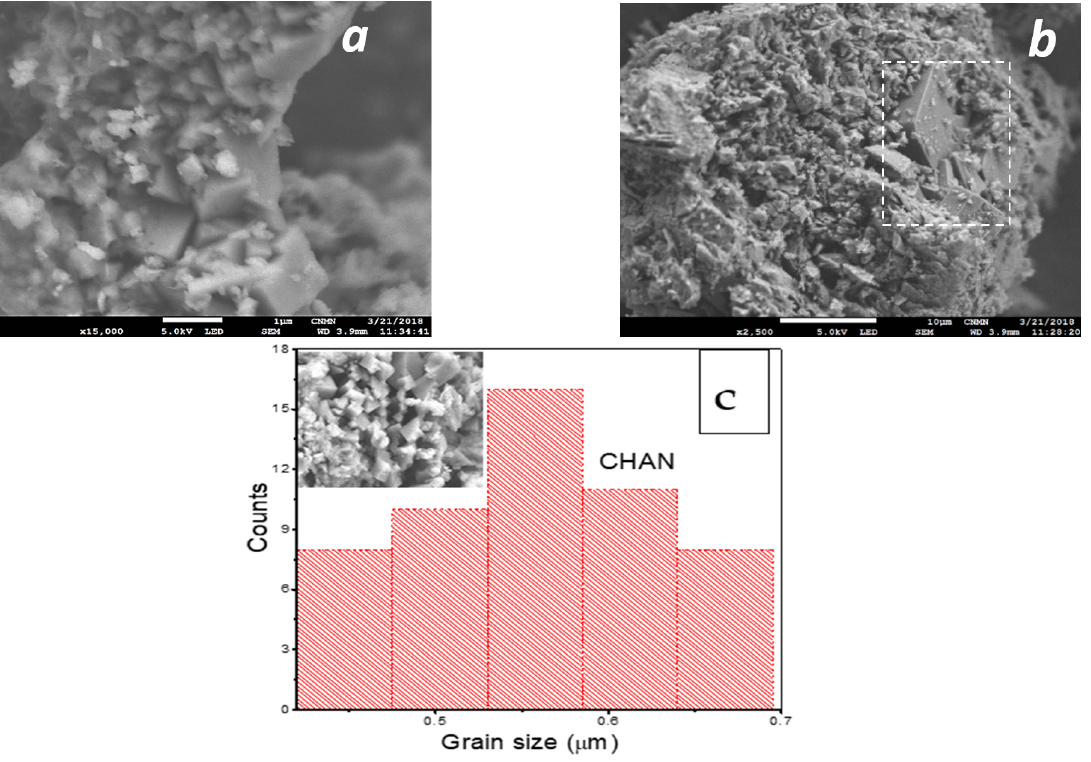
Figure 3. Micrographs of: ( a ) CHAN—×15,000, ( b ) accompanying crystalline phase, clinoptilolite, and ( c ) particle size histogram chabazite zeolite.